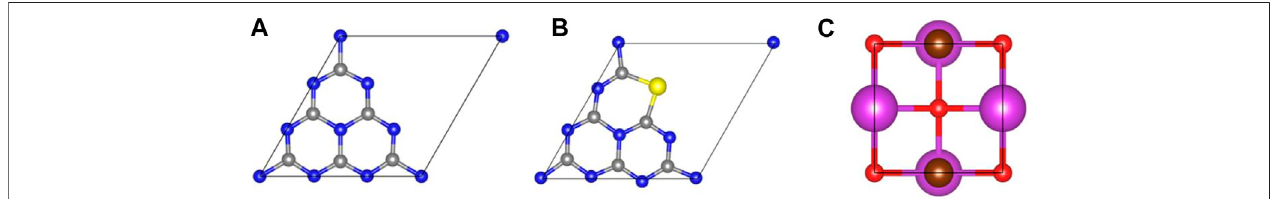
FIGURE 1 | Optimized geometric structures of monolayered g-C 3 N 4 , S-g-C 3 N 4 , and BiOBr. The C, N, S, Bi, O, and Br atoms are represented by the grey, blue, yellow, purple, orange, and brown balls, respectively.